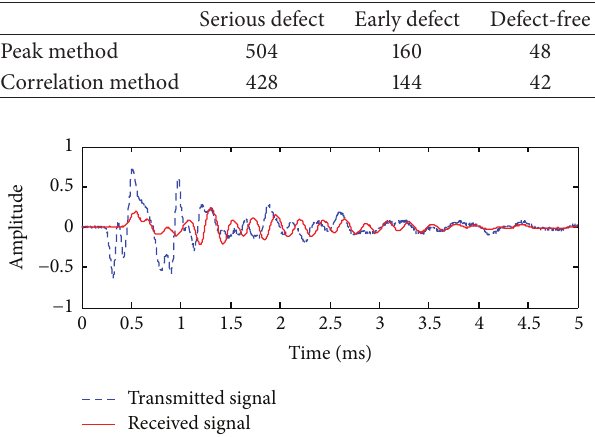
Table 1: Flight time obtained by two methods ( 𝜇 s).